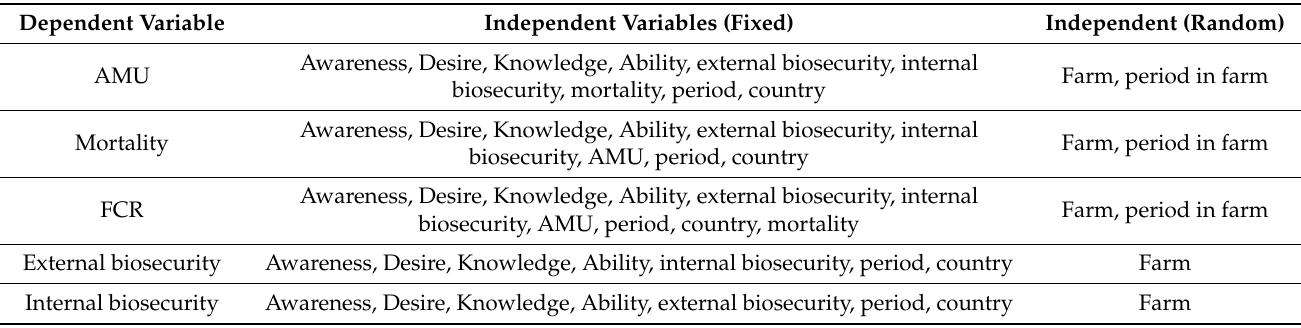
Table 4. Overview of the relationships evaluated in this study with different dependent, fixed, and random variables. Dependent